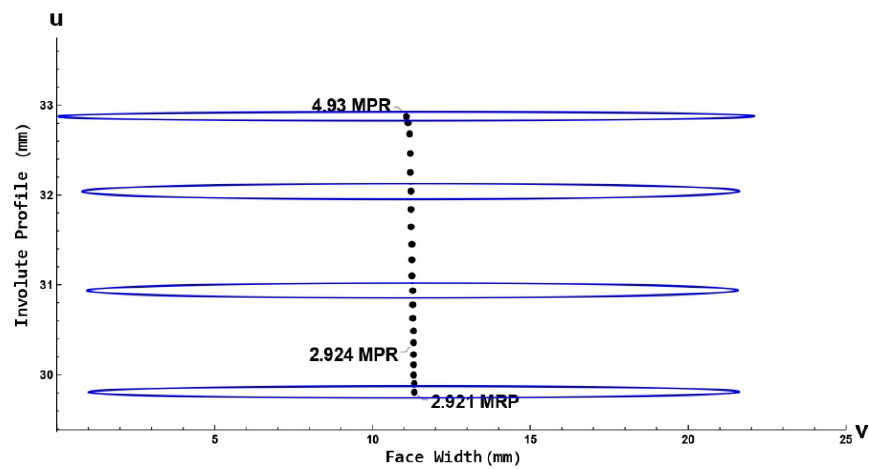
Figure 16. The MPR of crowned spur gears with a minimum amount of circular crowning and tip relief for an out-of-plane misalignment of 0.01° (0.17 mrad).